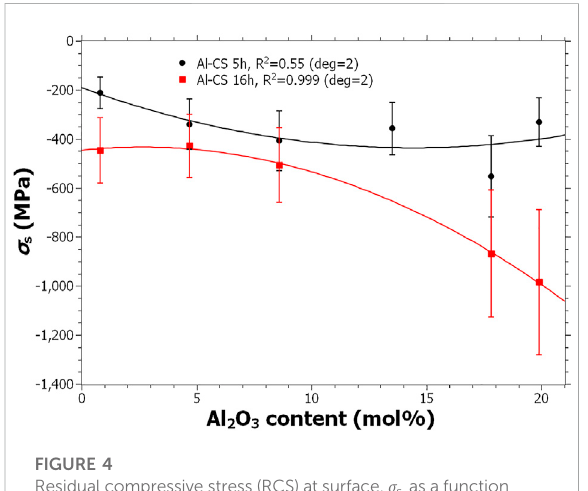
FIGURE 4 Residual compressive stress (RCS) at surface, σ s, as a function of Al 2 O 3 content. The lines are polynomial fi ts of the second degree.